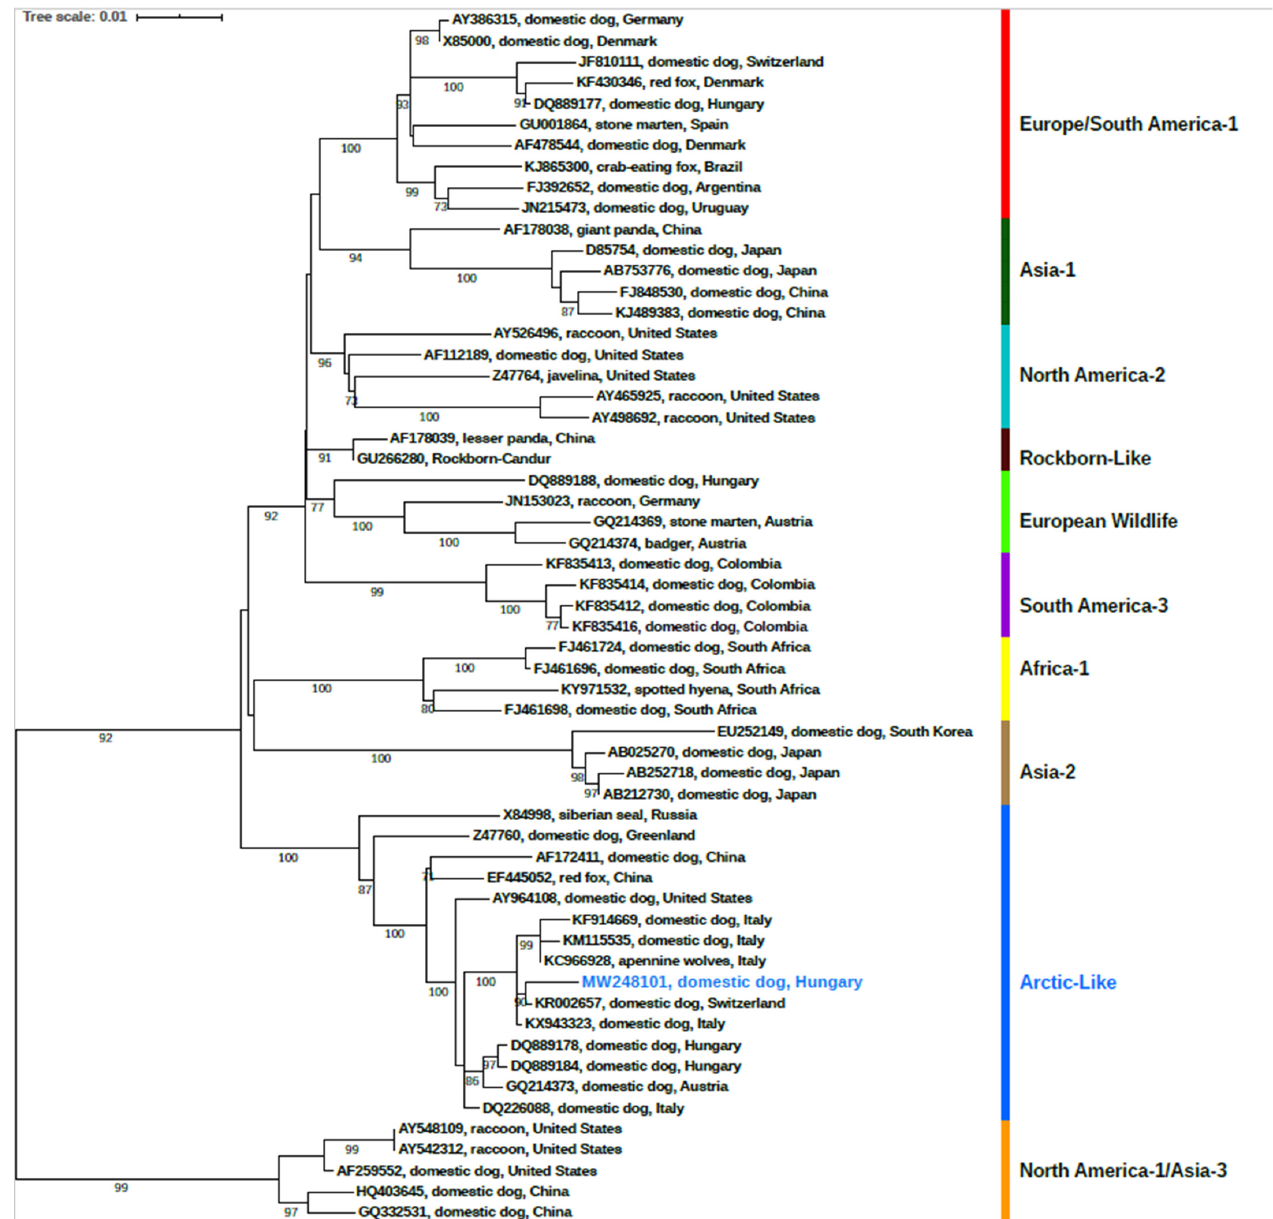
Figure 1. Phylogenetic tree based on the full-length hemagglutinin (H) nucleotide sequences. Phocine distemper virus (PDV) (GenBank accession number: AF479277) was used as an outgroup to root the phylogenetic trees. Bootstrap values lower than 70% are not shown. The sequence of interest is highlighted in bold and blue color.